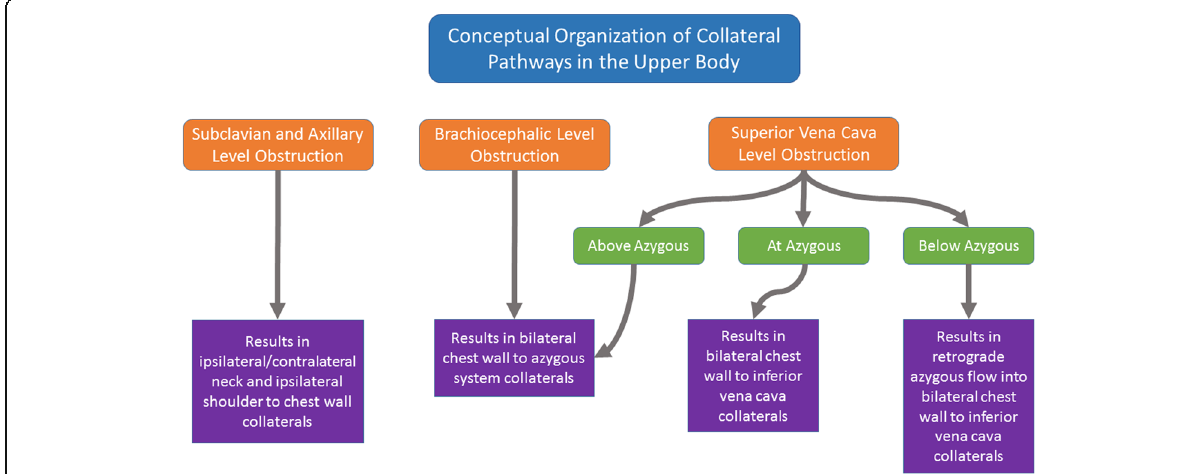
Fig. 1 Our conceptual organization of collateral pathways in the upper body